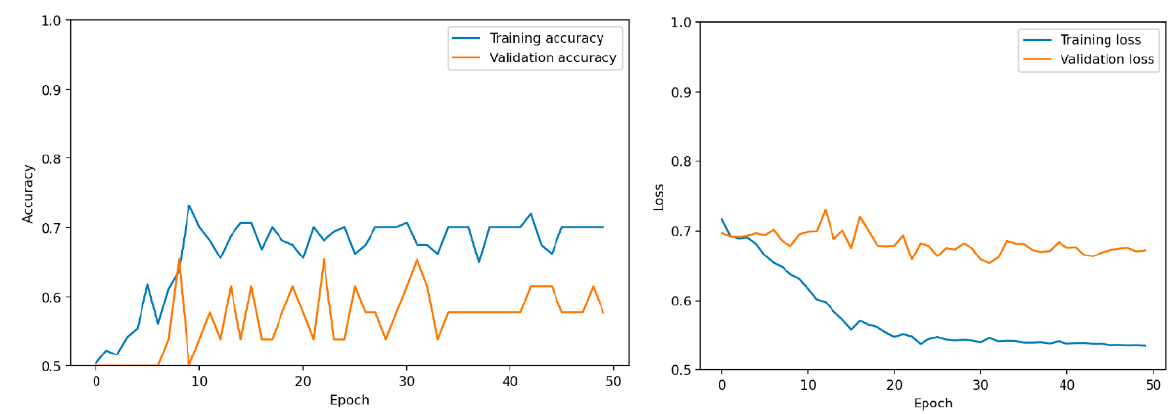
Figure 5. Results of the proposed CNN model for 50 epochs for the one-week-long geomagnetic time series. Left : estimated accuracy based on the training and validation datasets. Right : evolution of the cross-entropy loss for the training and validation datasets.